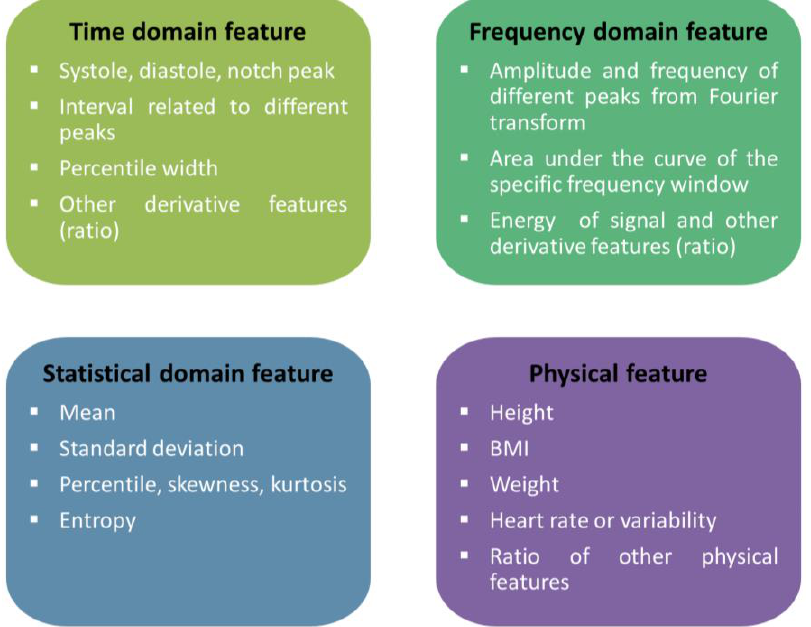
Figure 8. A summary of features used from biomedical signals (typically PPG wave) to create a model for BP measurement model for BP measurement (cuffless-noninvasive).